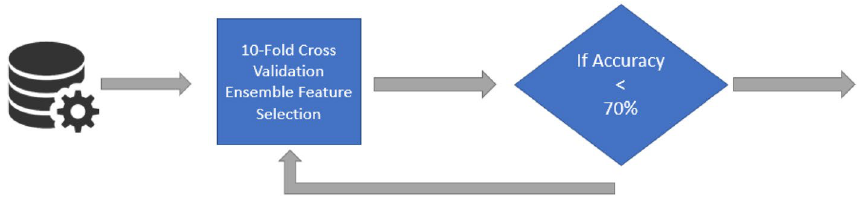
Figure 5. Overview of the REFS algorithm using the 10-fold global accuracy > 70% as a stop parameter.